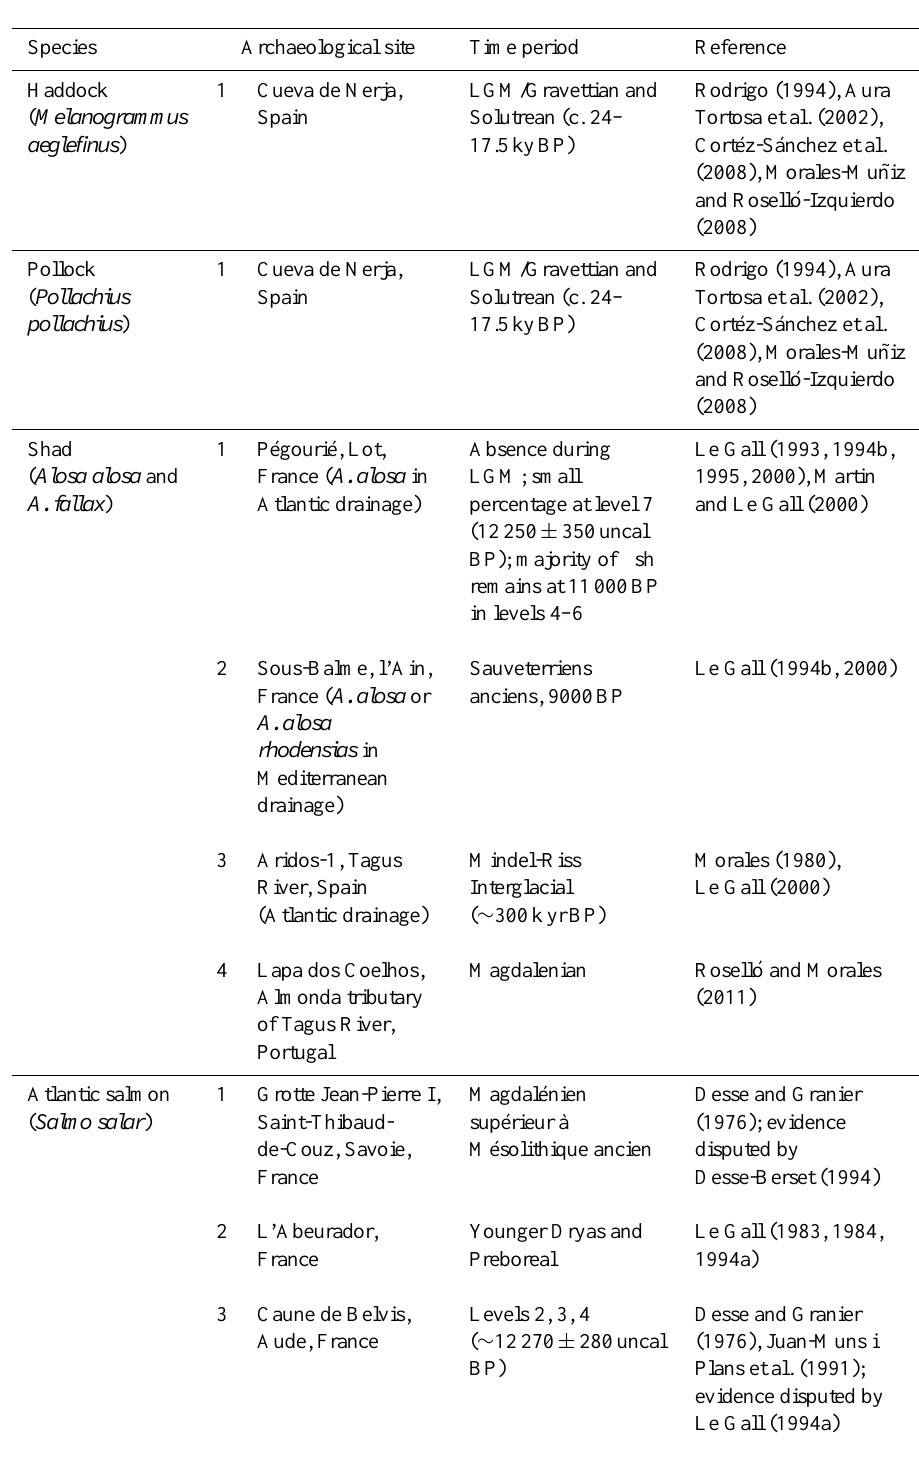
Table 1. Location of presence/absence of the remains (or artwork) of haddock, pollock, shad, and Atlantic salmon in pre-Holocene archaeo- logical sites outside their present geographic range. The indices in the table identify the location of the archaeological sites in Figs. 3 and 6. Allis shad ( Alosa alosa ) and twaite shad ( Alosa fallax ) are placed together in the table because their archaeozoological remains are often difficult to distinguish. For the time period of the archaeological site, uncal refers to uncalibrated radiocarbon dates. (C. Bonsall reports an error in Table 1 of Pickard and Bonsall, 2004, which shows the Mesolithic remains of allis shad at Advik, Varanger fjord, Norway but is not found in the primary source of Renouf,